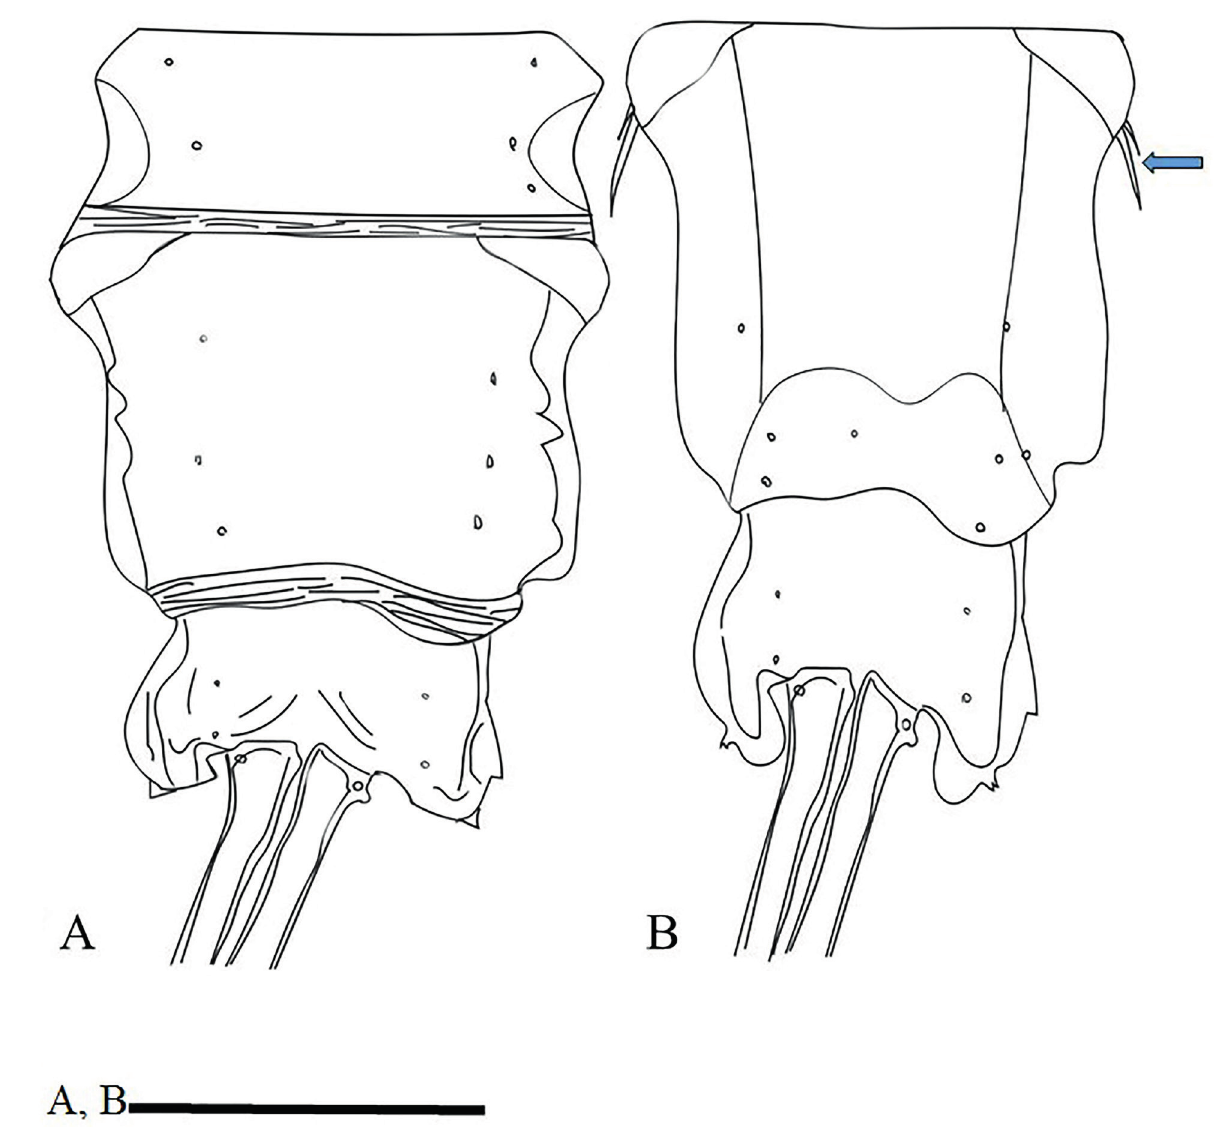
Figure 5. Clausidium persiaensis sp. nov. A, urosome, dorsal; B, urosome, ventral. Arrow indicates the P6 (female). Scale bar: 50 μm. row of spinules and 1 lateral seta at proximal